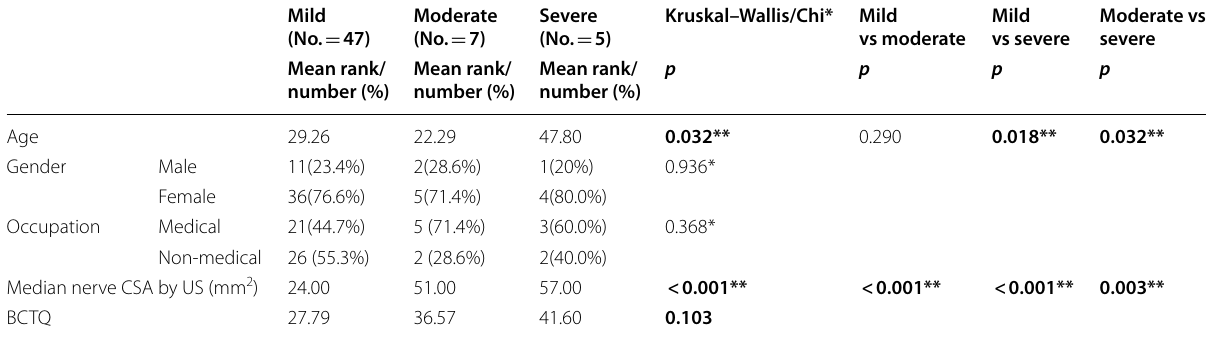
CSA cross sectional area, US ultrasound, BCTQ Boston carpal tunnel questionnaire